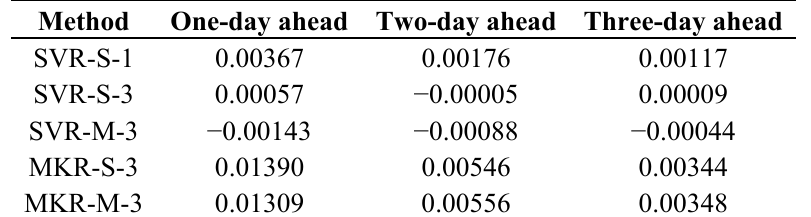
Table 8. Average APP results for WTI crude oil price prediction (total 14